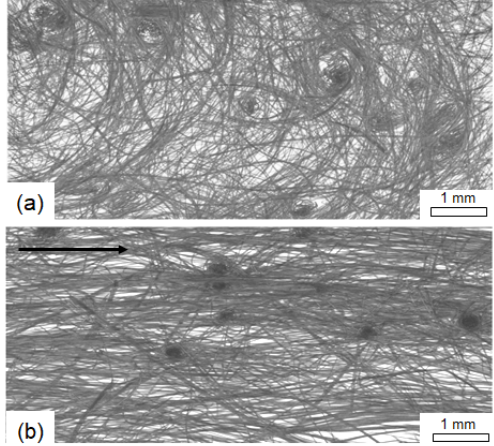
Figure 2. Evolution of fibre orientation distribution function with the applied strain. ( a ) As-receive nonwoven fabric and ( b ) after 40% of deformation along the transverse direction (TD) [15].